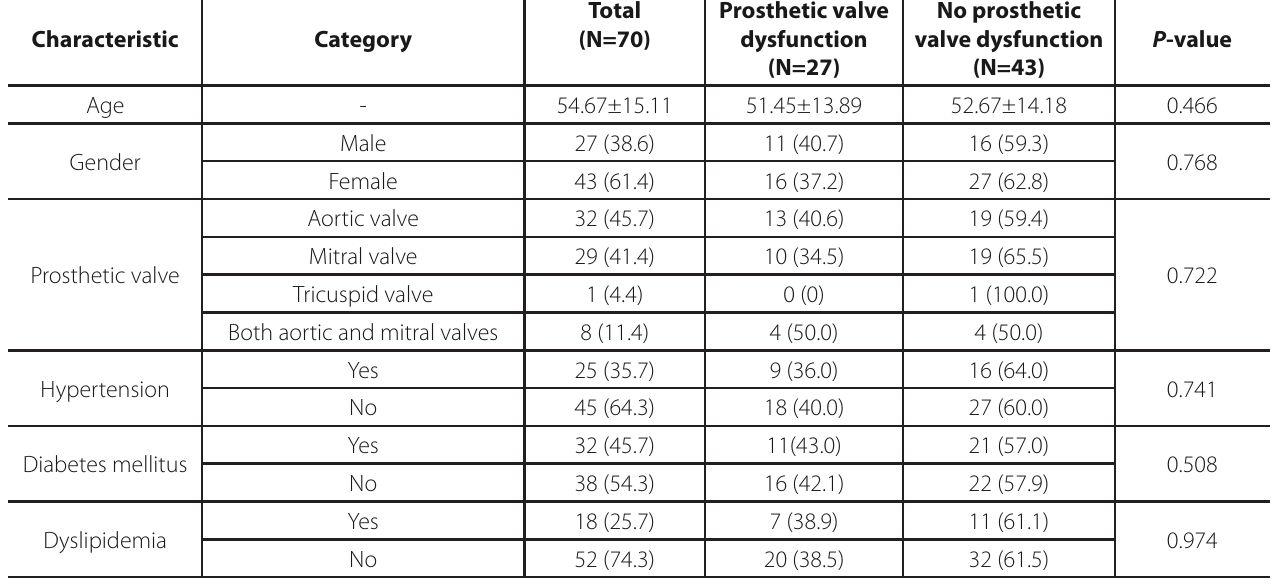
Table 1 . Baseline characteristics of